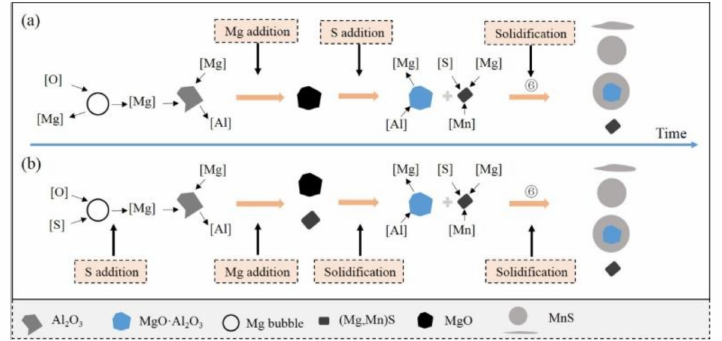
Figure 10. Formation and evolution mechanism of inclusions with different adding order of magnesium and sulfur for Fe-Mg-Al-Mn-O-S